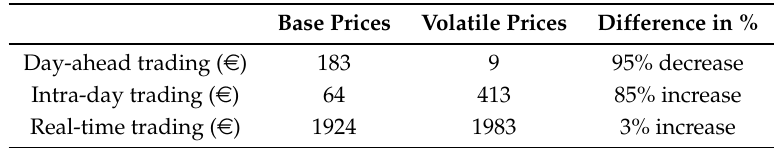
Table 4. Day-ahead, intra-day and real-time market trading with increased volatility of market prices; χ =